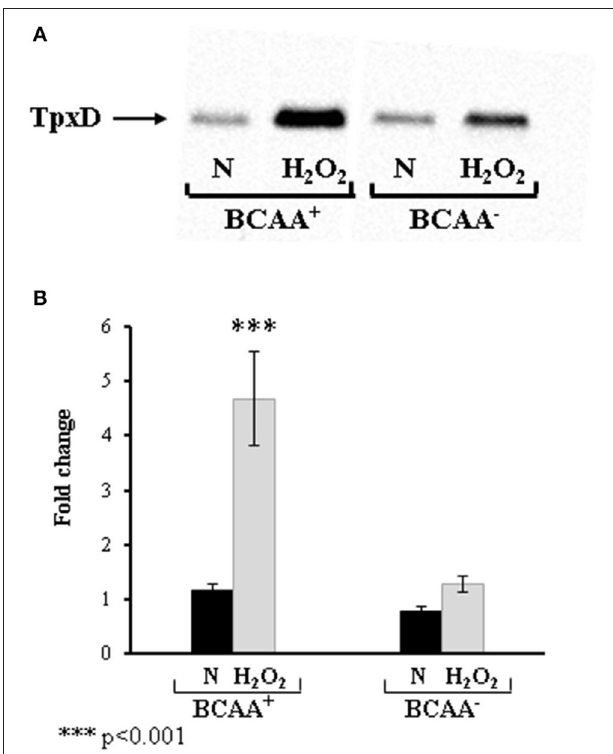
FIGURE 5 | Effect of BCAA on TpxD expression in bacteria challenged with H 2 O 2 . TpxD synthesis and expression levels were determined by Western blotting (A) and by RT-PCR (B) in D39 grown anaerobically (N) in CDM with (BCAA + ) or without (BCAA-) BCAA. Bacteria were grown to OD 620 = 0.25 and then challenged with 1 mM H 2 O 2 for 40 min. Control cultures were incubated without the addition of H 2 O 2 . Separated proteins were electroblotted onto 0.45 µ m nitrocellulose membrane, and stained with Ponceau S to ensure equal loading, before incubation with antibodies. Values are the mean of duplicate determinations of at least two independent experiments, and were normalized to the expression level of D39 grown anaerobically in medium containing BCAA. Bars indicate standard deviation. Significant alterations in gene expression compared to bacteria grown without H 2 O 2 were determined using Student’s t